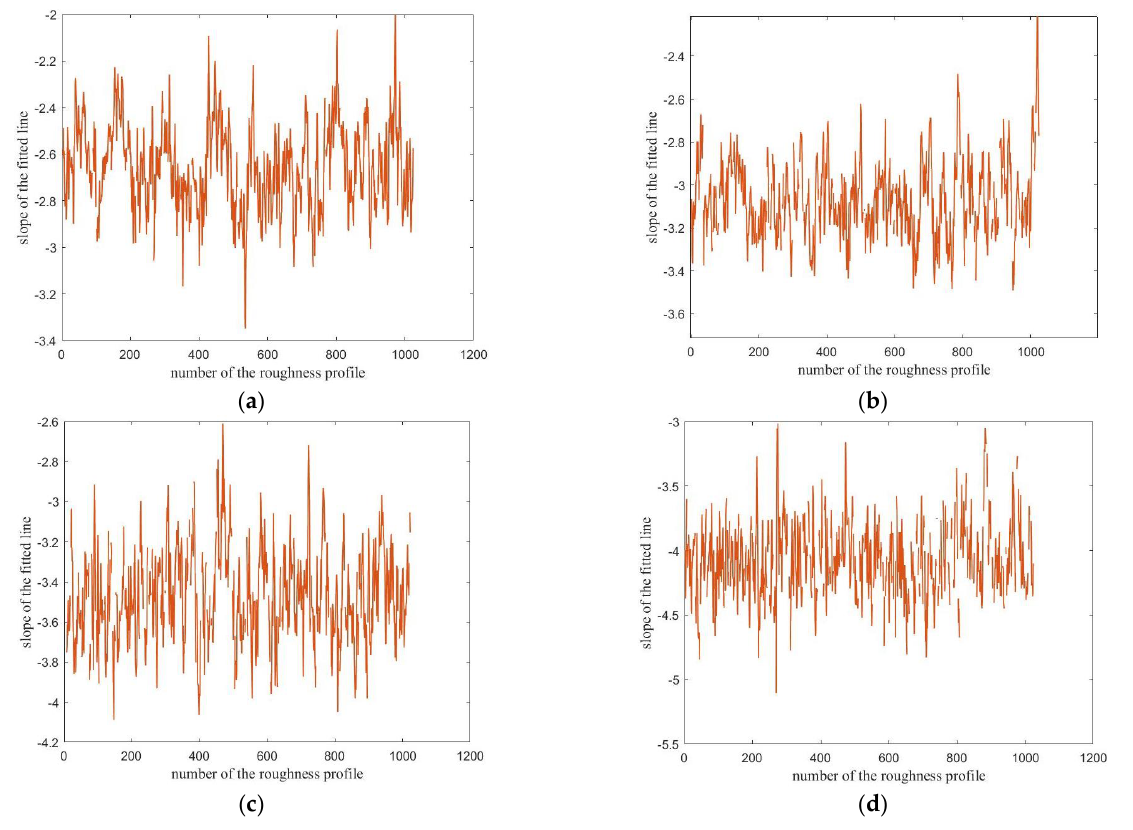
Figure 6. Results of 1024 slopes under each scale (WC-Ni). ( a ) 100 × ; ( b ) 50 × ; ( c ) 25 × ; ( d ) 10 × .